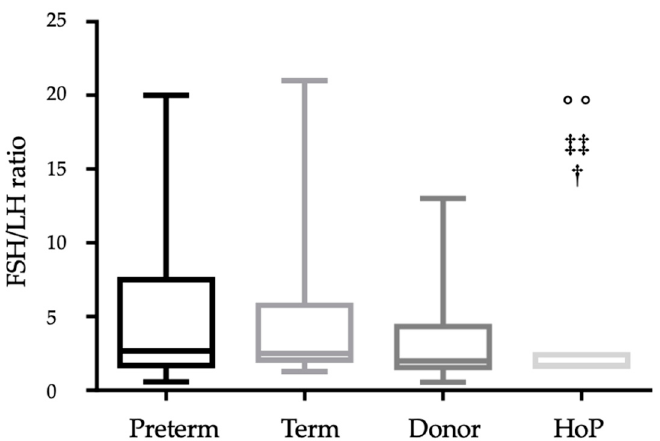
Figure 1. FSH:LH ratio in preterm, term, donor, and pasteurized donor milk. °° p < 0.01 versus preterm milk; ‡‡ p < 0.01 versus term milk; † p < 0.05 versus donor milk.